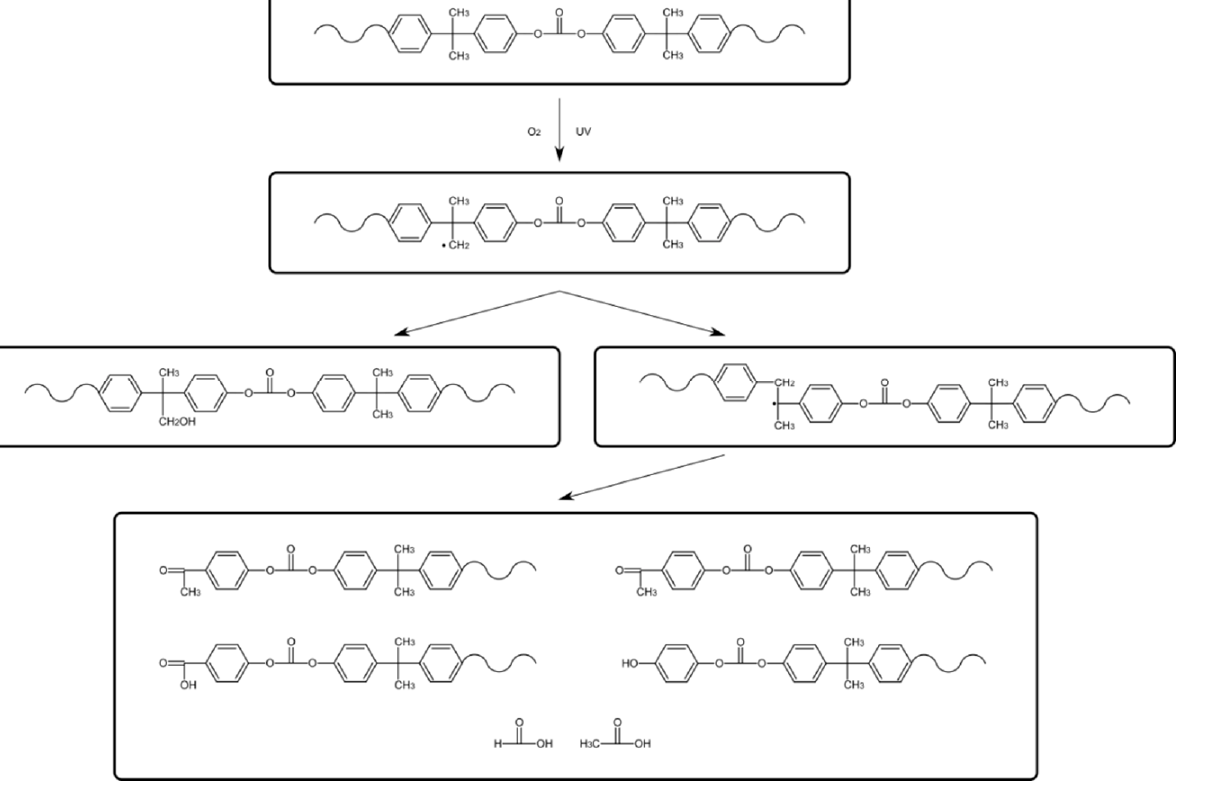
. Figure 2. Photodegradation of polycarbonate. The first group of samples containing MDI/PMDI in their composition and without the addition of hydrated magnesium silicate is characterized by the lowest YI value. Among this group of samples, no relation between the amount of MDI/PMDI addition and the YI value was found (Table 2). Table 2. Yellowing index of analyzed composites .